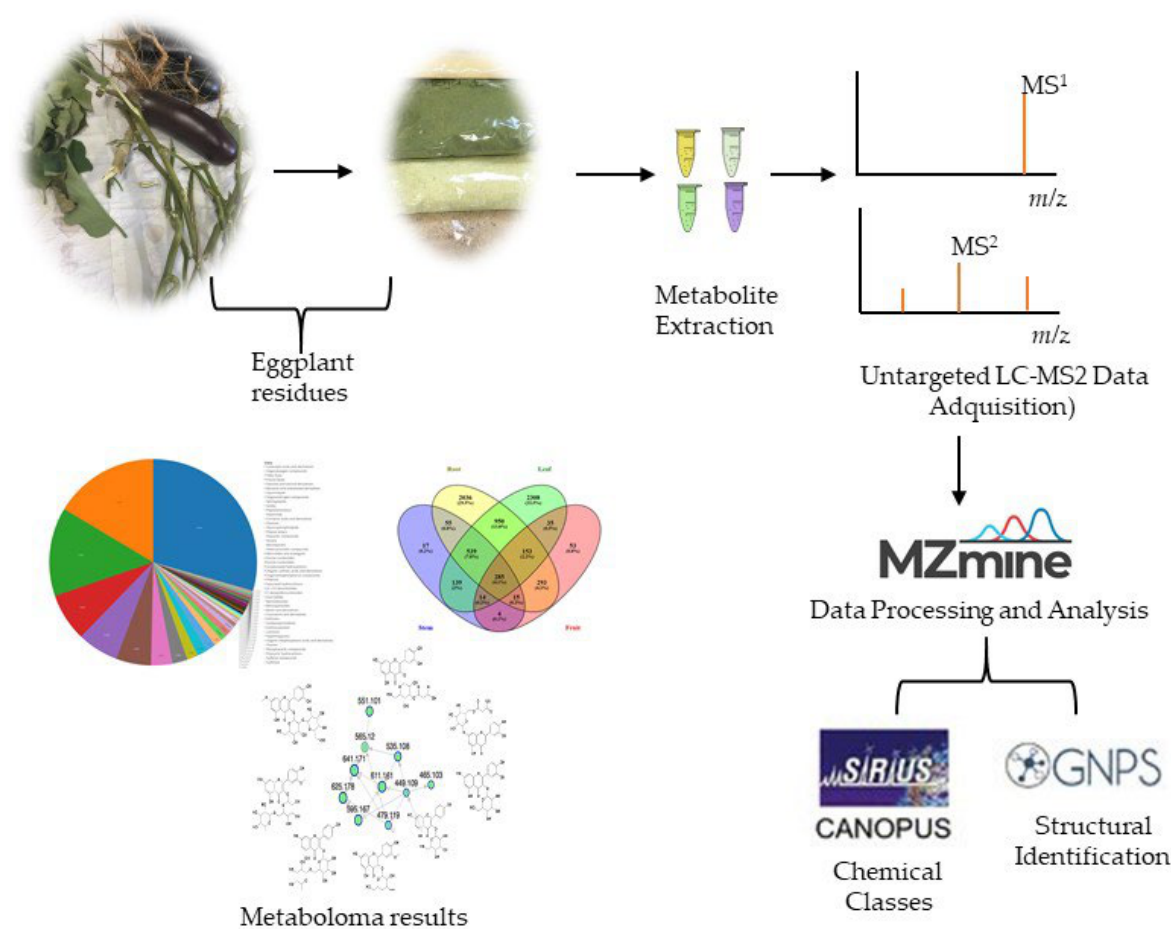
Figure 6. Methodological strategy of metabolomic analysis.